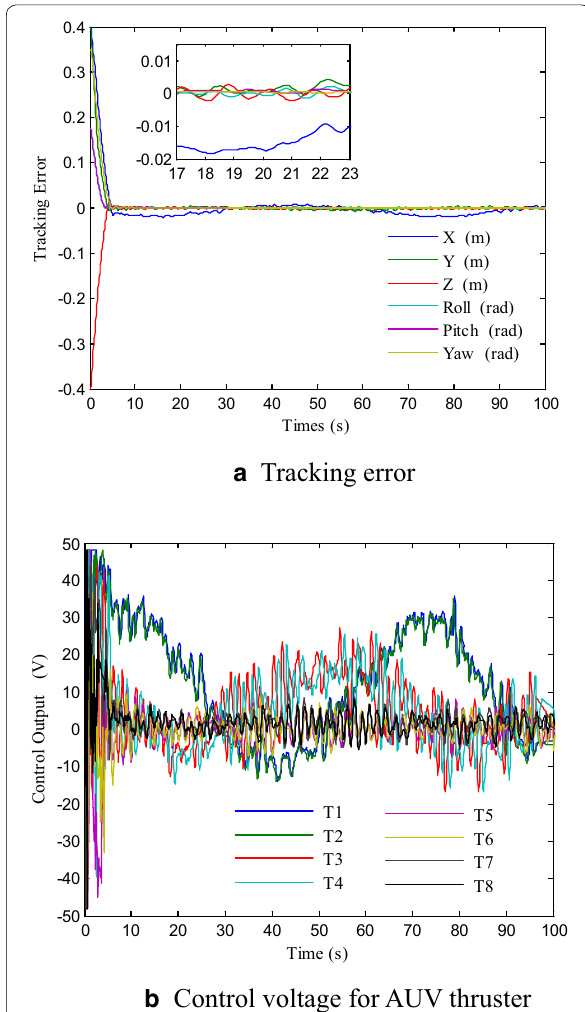
Figure 6 Chattering‑reduction effect of the proposed methods